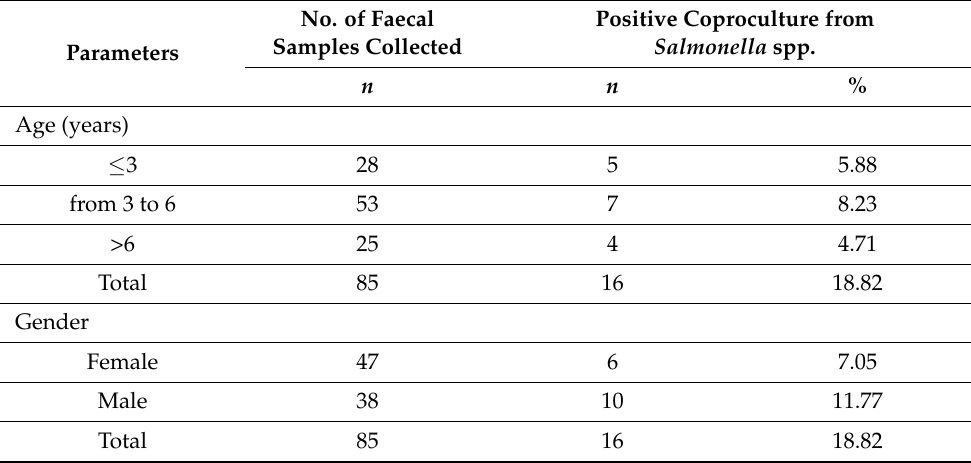
Table 1. Distribution of the isolated Salmonella strains according to age and gender. No. of Faecal Positive Coproculture from Salmonella spp. Samples Collected Parameters n